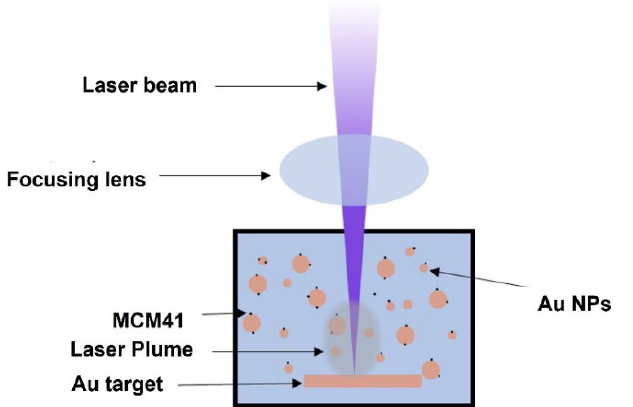
Figure 1. Schematic illustration of the use of the PLAL method to prepare Au-decorated MCM-41 NPs.